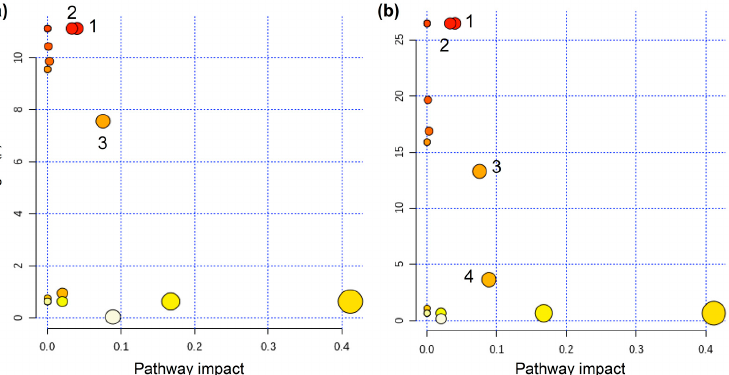
Figure 4. Pathways associated with the metabolism response for HTC and ETC cassava over ( a ) nine months and ( b ) 15 months of harvesting time. Legend: 1—Citrate cycle (TCA cycle); 2— Sulfur metabolism; 3—Galactose metabolism; 4—Starch and sucrose metabolism.